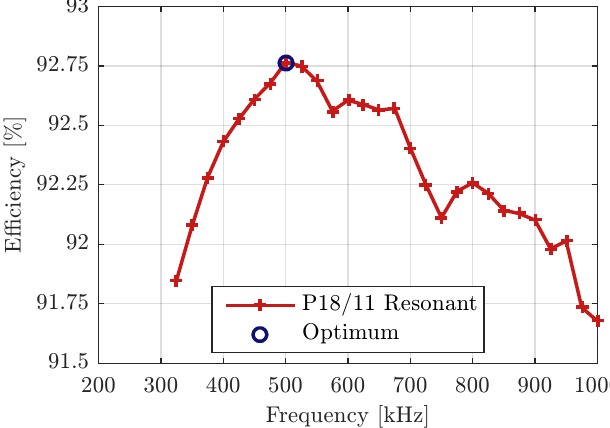
Figure 5. Optimization results: Efficiency as a function of frequency for the P18/11 resonant transformer in the feasible output power